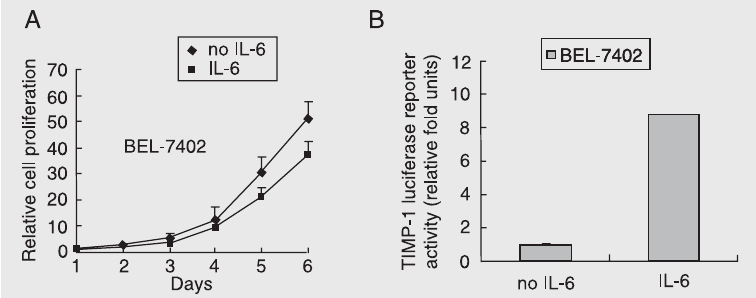
Figure 2. Inhibition by interleukin-6 (IL-6) of the proliferation of the hepatocarcinoma cell line BEL-7402 was accompanied by induced tissue inhibitor of metalloproteinases (TIMP-1) expression. A , BEL-7402 cells were collected by trypsinization and resuspended in culture medium after being treated or not with IL-6. The number of cells was counted with a hemocytometer. B , Cells were transfected with the TIMP-1 reporter plasmid and treated or not with IL-6. TIMP-1 expression induced by IL-6 was analyzed according to the luciferase